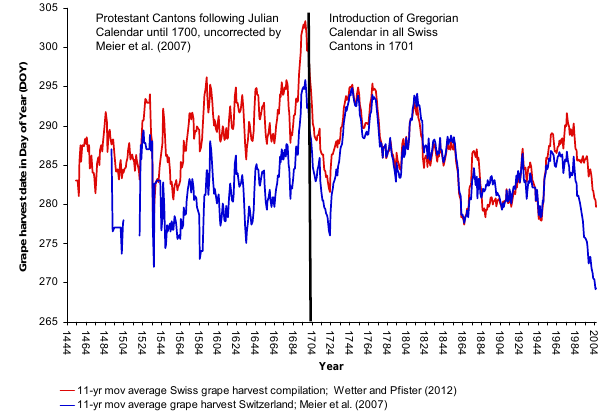
Fig. 1. Noncalendar-style corrected GHD by Meier et al. (2007) vs. corrected GHD by Wetter and Pfister (2012) Fig. 1. Non-calendar-style corrected GHD by Meier et al. (2007) vs. corrected GHD by the authors of this The new Swiss GHD series Switzerland is located in central Europe and divided up into three major geographic regions, namely a) the Alps, b) the Jura Mountains and their foothills and c) the intermediate region called the Swiss Plateau, where most vineyards are located. The country is situated in a zone of transitional climate influenced by both maritime and continental air masses. Figure 2 (Fig. 2, upper part) summarizes the spatial location of the 17 local GHD together with the metadata used for merging the local series into a main series (Fig. 2.; box). The lower part of Figure 2 shows the composition of the main series over time.